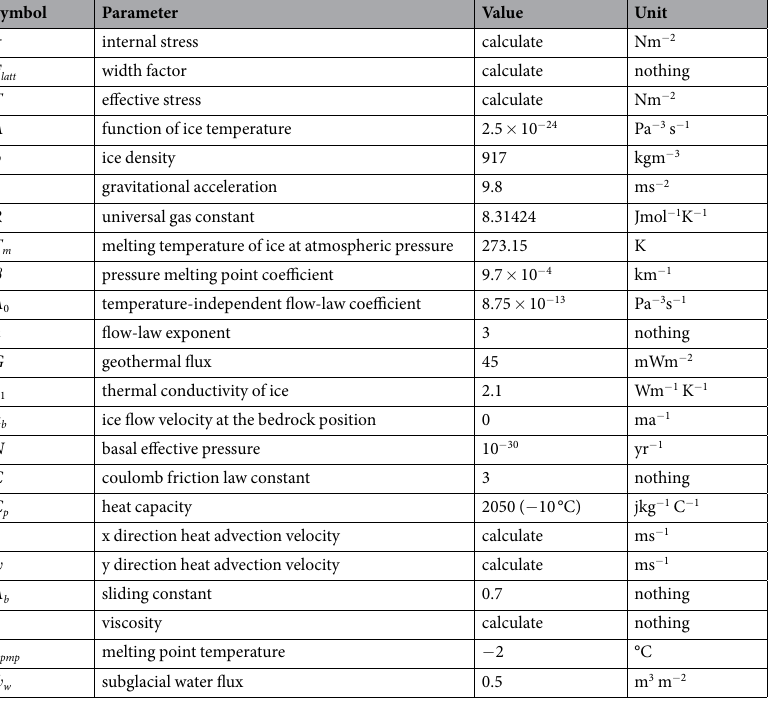
Table 1. The value of some parameters in the